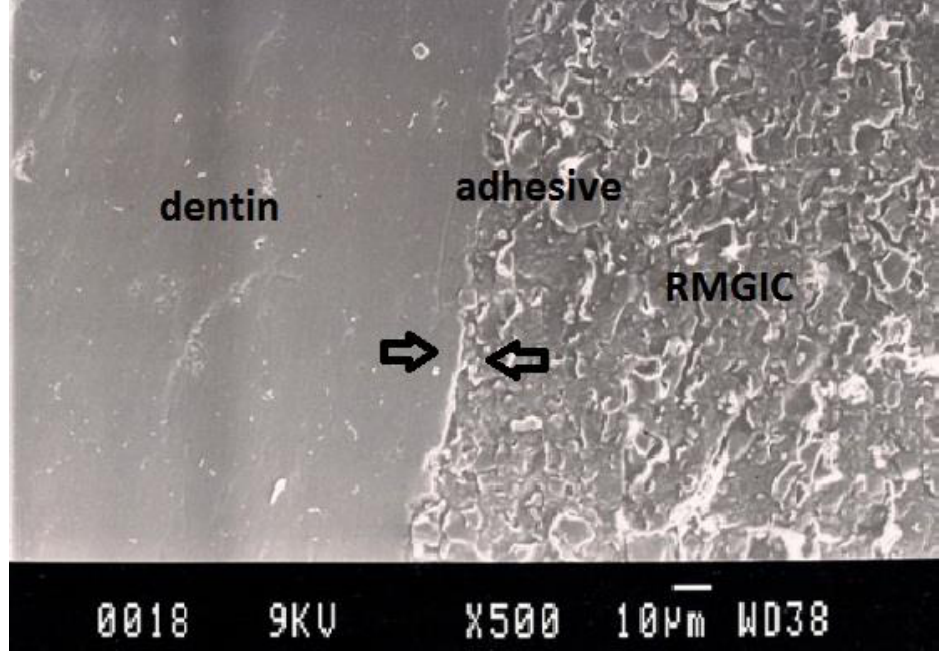
Figure 7. Representative SEM photomicrograph of a Group 6 specimen. The arrows indicate good adaptation between resin-modified glass ionomer cement, adhesive and